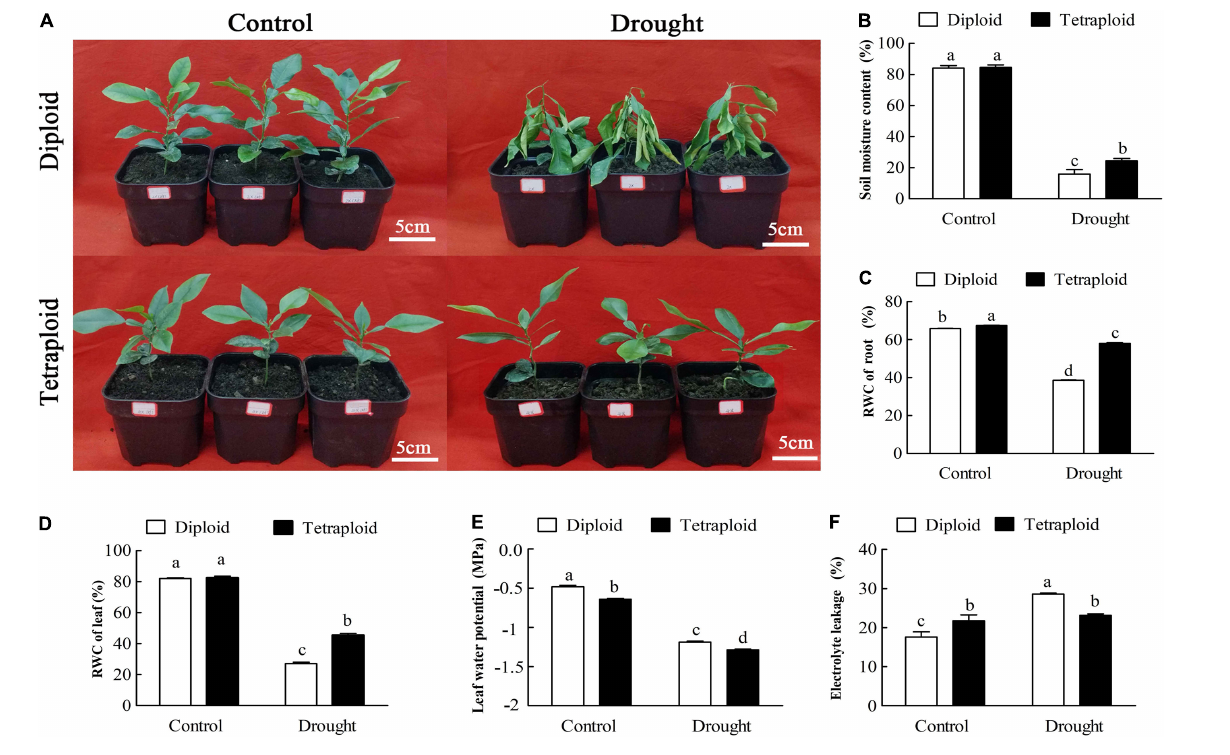
FIGURE 2 | Morphological and physiological analysis between tetraploids and diploids Citrus wilsonii in response to drought stress. The morphological changes of tetraploids and diploids Citrus wilsonii under drought stress (A) ; physiological analysis in soil moisture content (B) , RWC of root (C) , RWC of leaf (D) , leaf water potential (E) , and electrolyte leakage (F) between tetraploids and diploids under drought stress. Each value is the mean of three biological replicates, and the vertical bars represent the standard errors. Values sharing the same lower case letters are not significant by ANOVA at P <